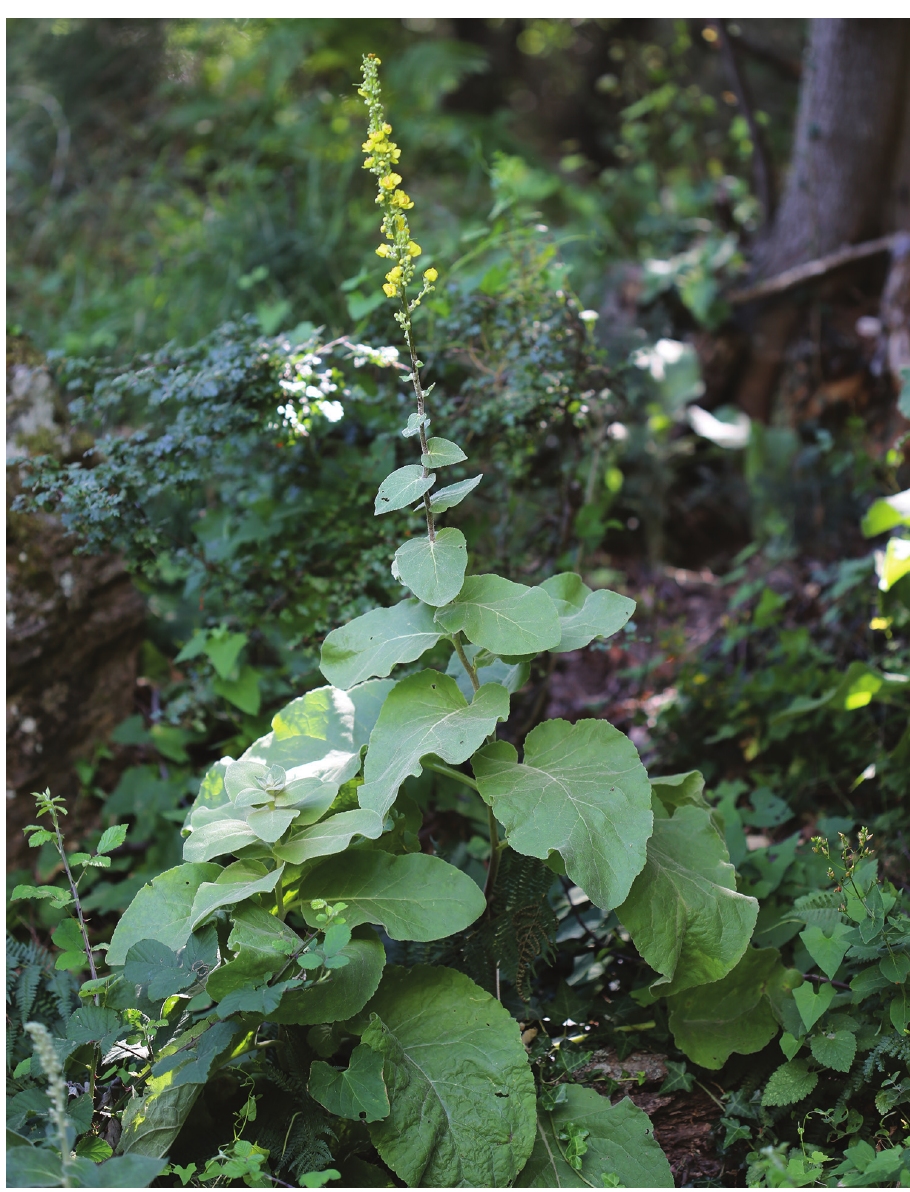
Figure 3. Verbascum delphicum subsp. delphicum var. filictorum Zografidis: Habit. A sterile stem is dis- cernible next to the flowering